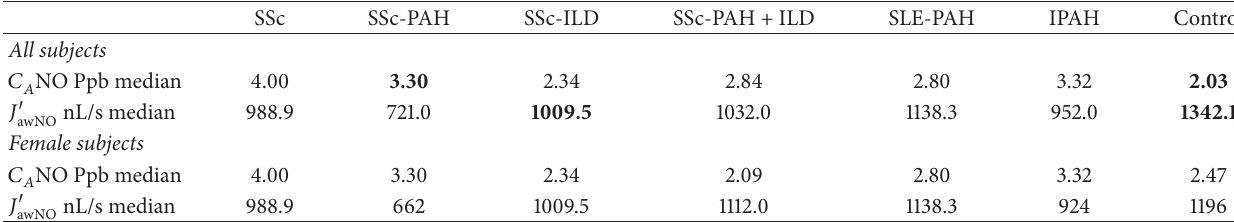
Table 3: Median 𝐶 𝐴 NO and 𝐽 󸀠 awNO by subgroup.